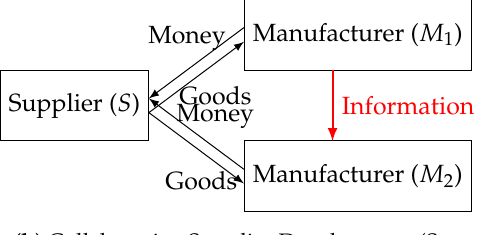
Figure 4. Collaborative: Simultaneous ( a ) and Sequential ( b ) supplier